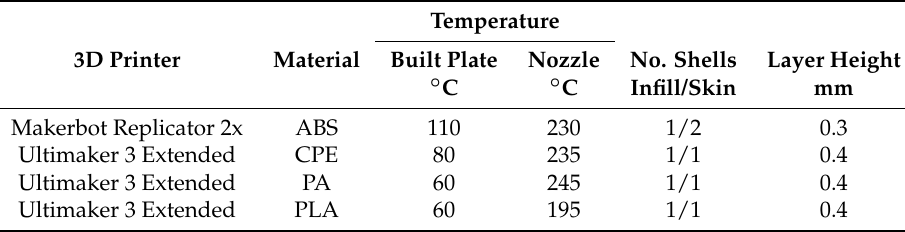
Table 3. Settings used for the preparation of 3D printed